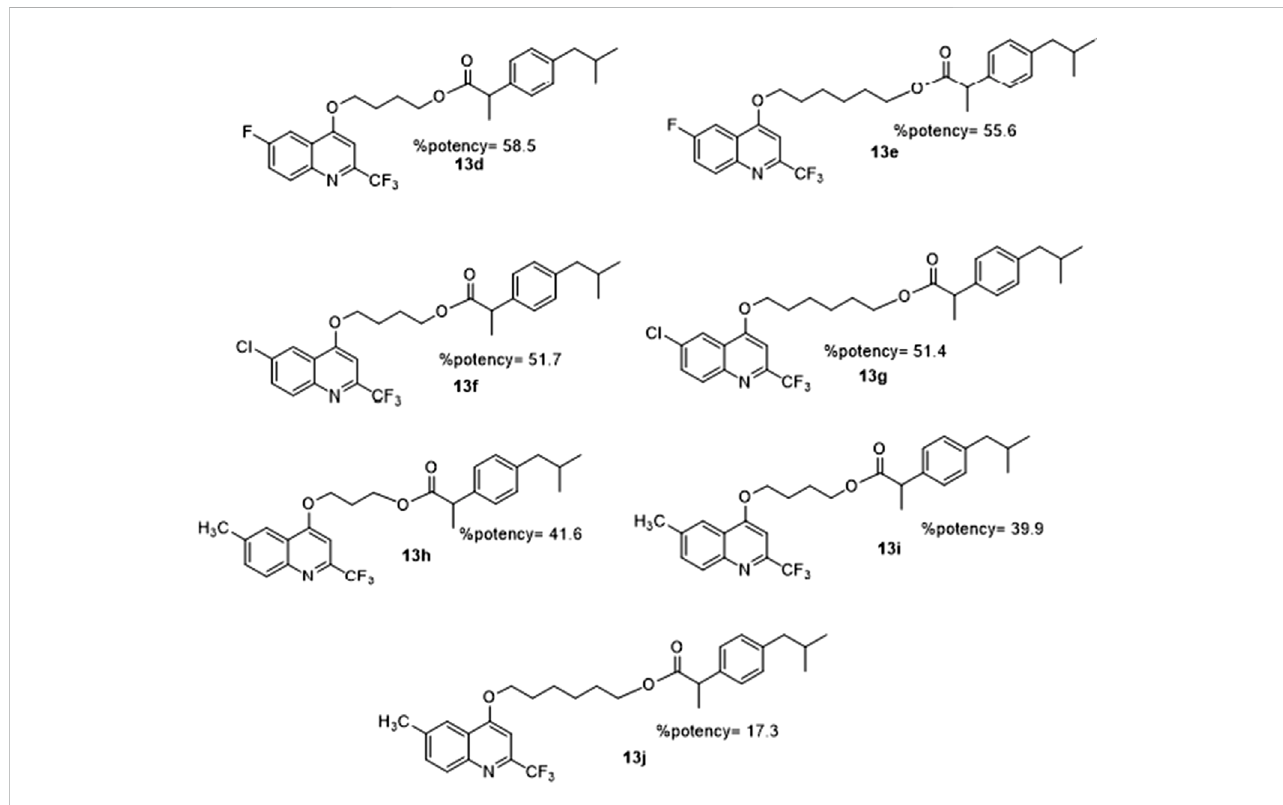
FIGURE 15 SAR activity of Ibuprofen-quinolinyl